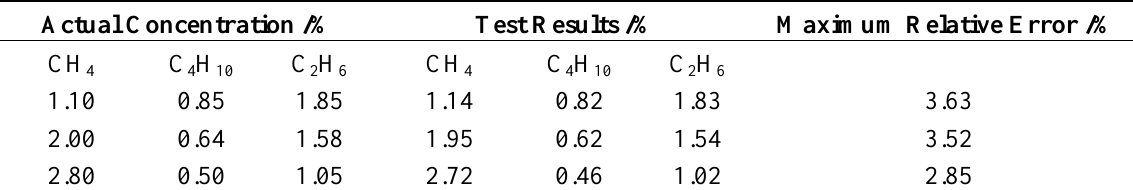
Table 1. Analysis results of combustible